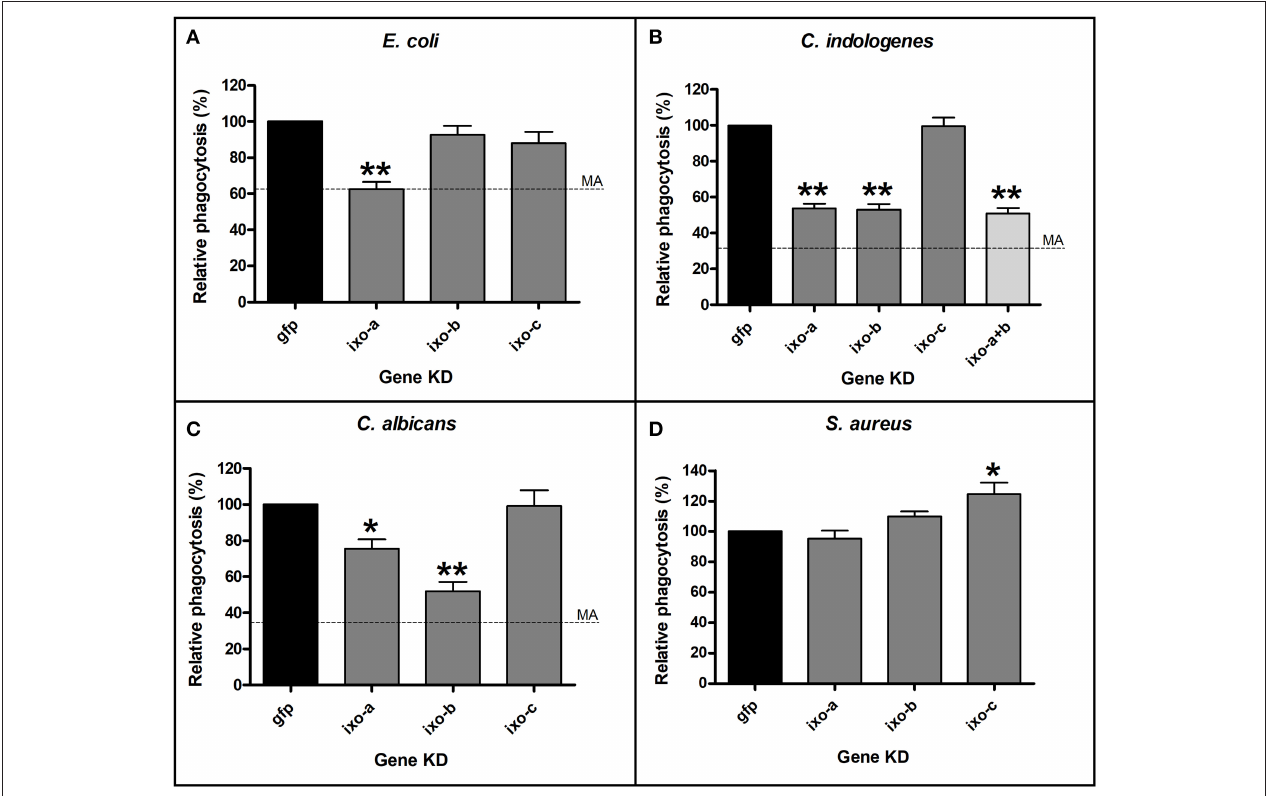
FIGURE 5 | Silencing of ixoderins impairs phagocytosis of microbes by tick hemocytes. Tick hemocytes acquired from the adult semi-engorged females after ixoderin KDs were incubated in vitro with E. coli (A) , C. indologenes (B) , C. albicans (C) , and S. aureus (D) . At least five independent slides with hemocytes were analyzed for each of biological triplicates. The level of phagocytosis in the dsGFP control was set as 100%. Dashed lines indicate phagocytosis after methylamine (MA) pre-treatment (no effect on S. aureus ). One and two asterisks indicate p -value < 0.05 and < 0.001, respectively.